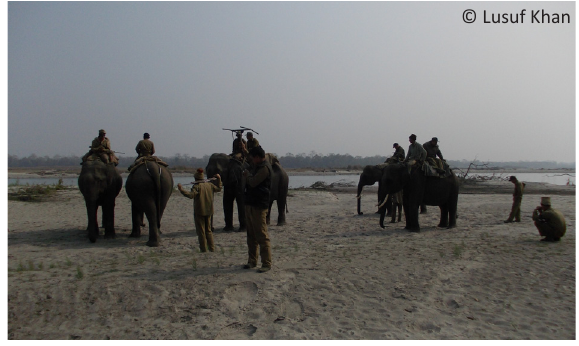
Image 4. Rhino monitoring team with